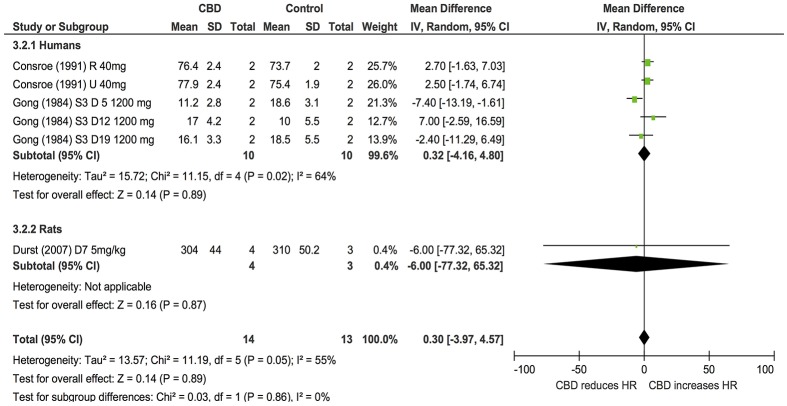
Changes in HR induced by chronic CBD dosing.